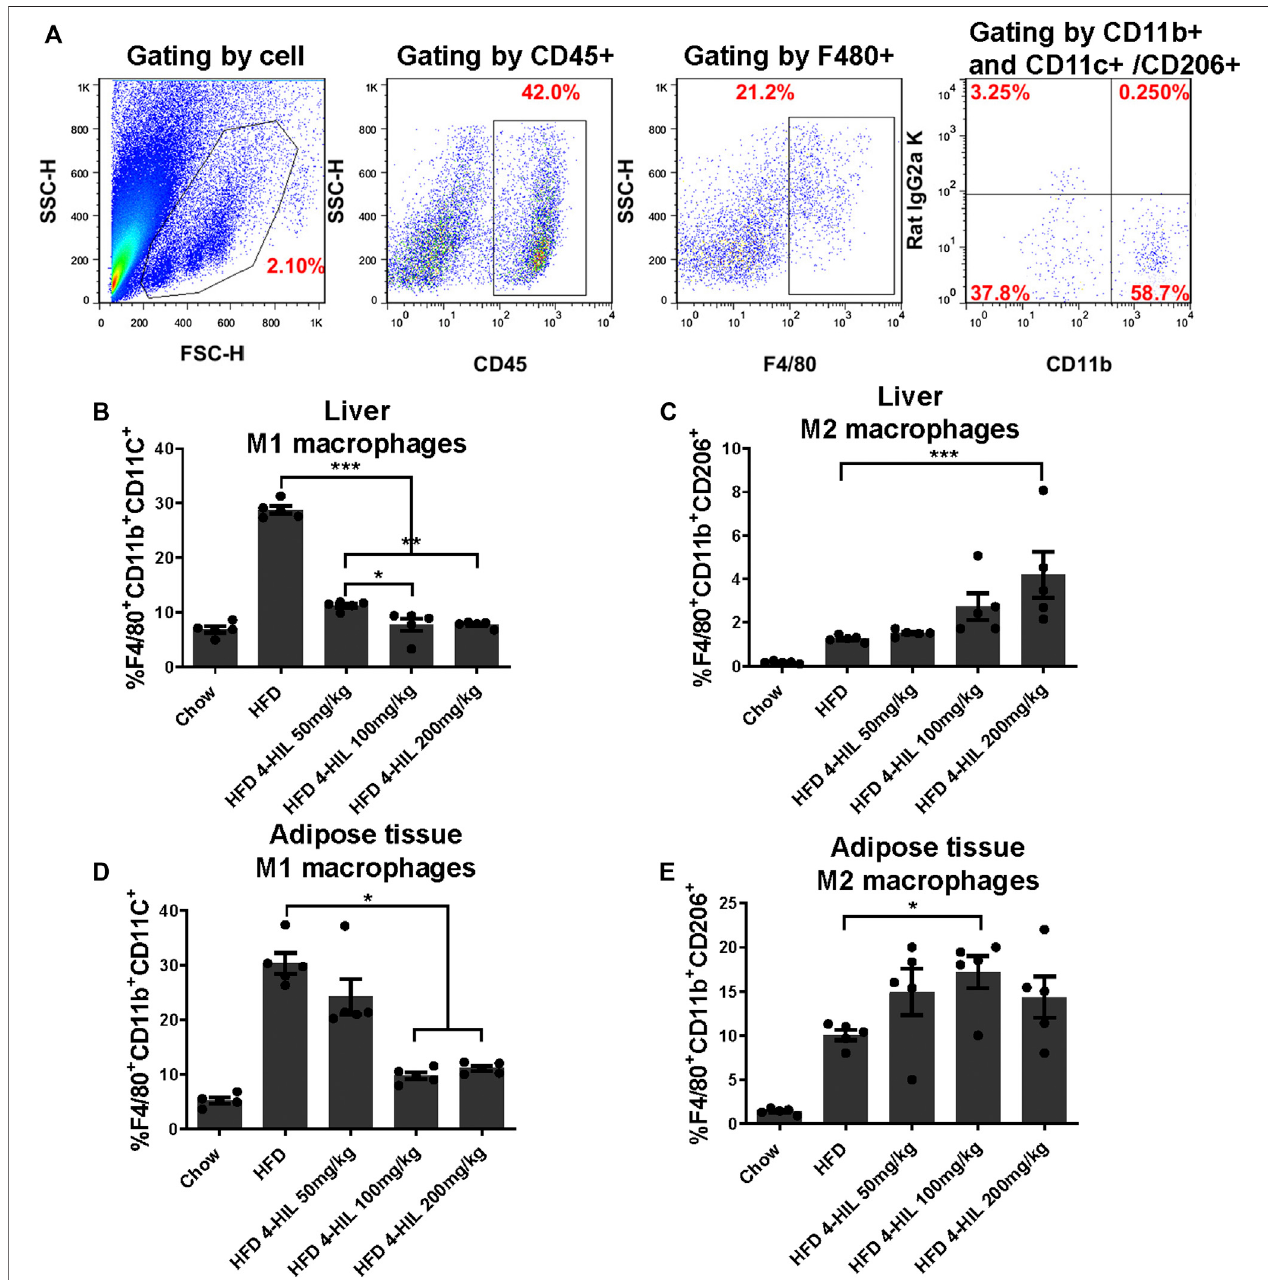
FIGURE 5 | Proin fl ammatory M-1-like CD11c + macrophages from HFD-fed mice are inhibited by 4-HIL in vivo . After the end of the period of 4-HIL administration, theliverandadiposetissuewereobtainedandthetissueswasprocessedtosinglecellsuspensions.Theantibodywasaddedandincubatedinthedark,andtheeffectof the 4-HIL administration on the macrophage was detected by fl ow cytometry. Typical fl ow cytometry shows the gating scheme of macrophages (A) . Fluorescence- activated cell sorting gating results of macrophage fl ow cytometry are shown in (B) – (E) .